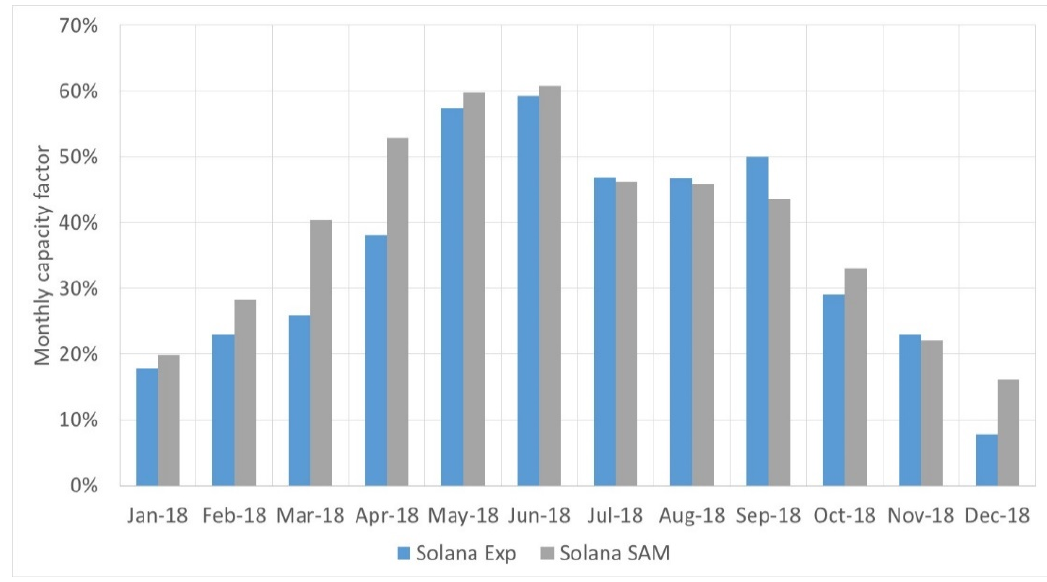
Figure 7. Comparison of monthly capacity factors of Solana from SAM and measurements.